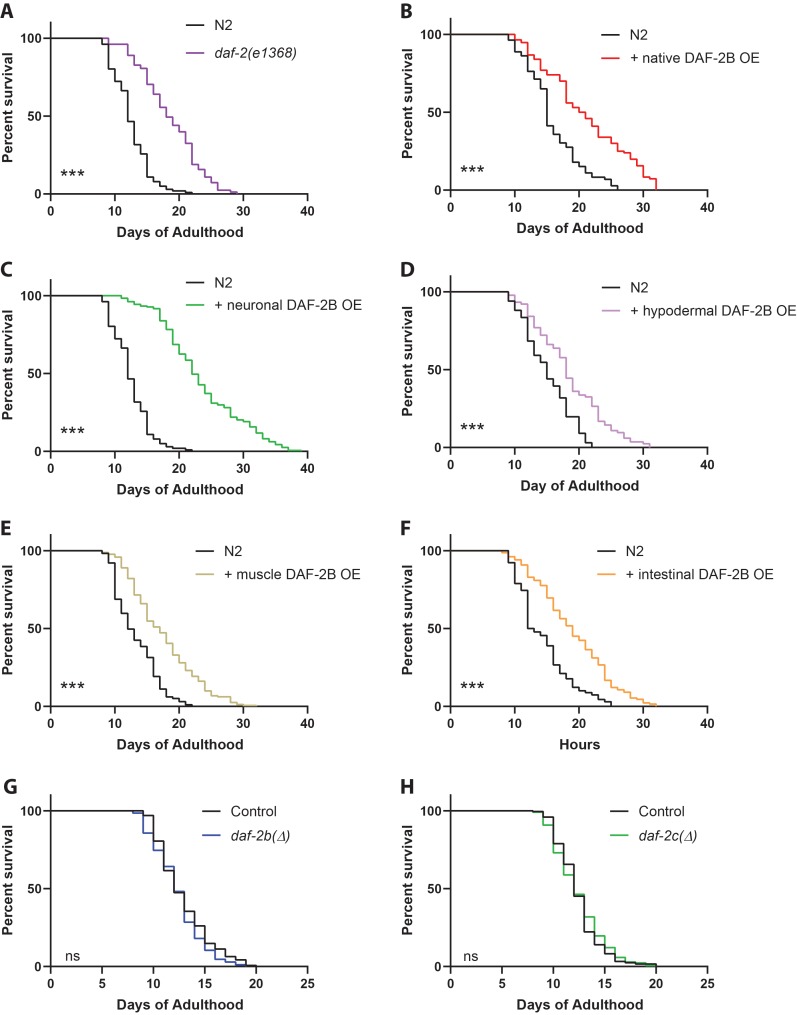
DAF-2B overexpression extends lifespan.(A) The daf-2(e1368) hypomorphic mutation confers lifespan extension. Overexpression of DAF-2B from the native daf-2 promoter (B), in the nervous system (C), in the hypodermis (D), in the muscle (E) or in the intestine (F) extends lifespan in wild type N2 animals. Genetic deletion of daf-2b (G) and daf-2c (H) has no effect on lifespan in wild type N2 animals. Log Rank test ns – not significant, ***p<0.001. Lifespan data are representative of n = 2 biological replicates for DAF-2B overexpressers and n = 3 for deletion strains. Summary data for all replicates are presented in Supplementary file 1.